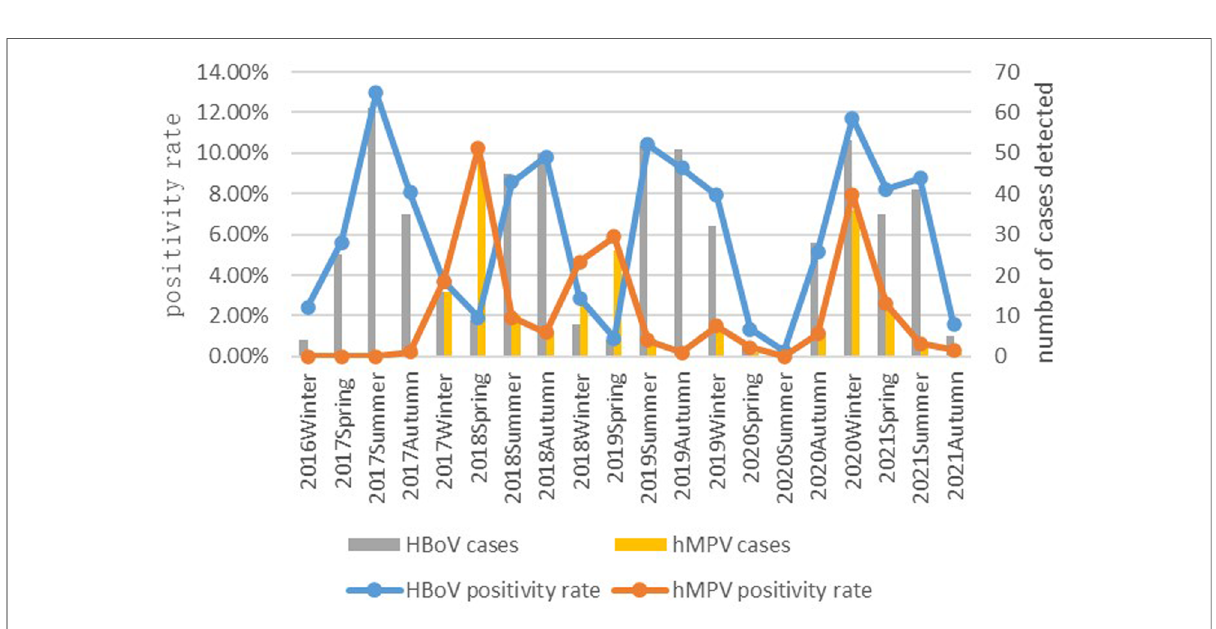
FIGURE 1 The prevalence of HBoV and hMPV in the past fi ve years by season is shown in Figure 1